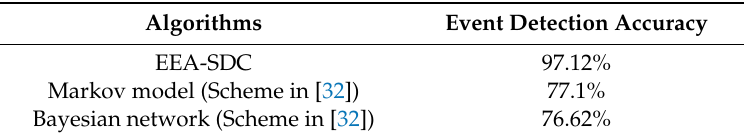
Figure 7. The accuracy of the event detection compared to the Markov model and Bayesian network. Table 4. The accuracy of the event detection of the proposed EEA-SDC with the Markov model and Bayesian network in the case of the Milan dataset.